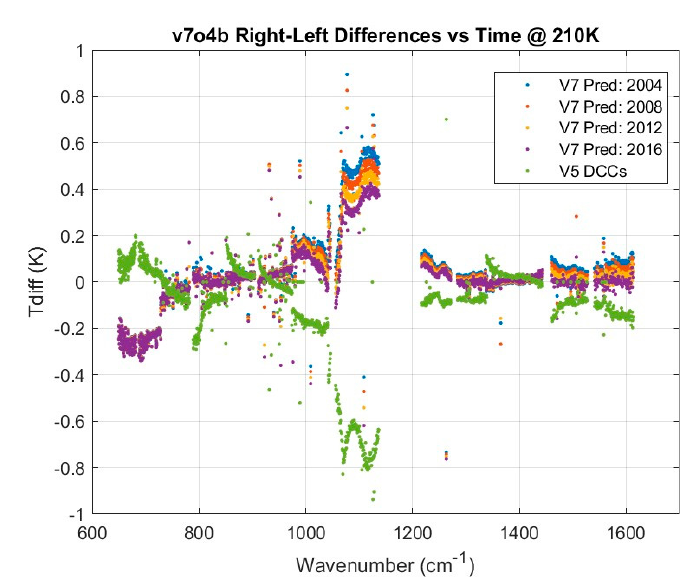
spectrometer interpolated to start of mission. ( b ) Phase of the spectrometer polarization interpolated to start of mission. ( c ) Offset coefficient. ( d ) Effective emissivity. ( e ) Nonlinearity coefficient. Error bars represent the standard deviation among the tests used to derive the coefficients; not the overall uncertainty in the coefficients. Error bars for V5 are not plotted since only one test per side was used to derive the coefficients.